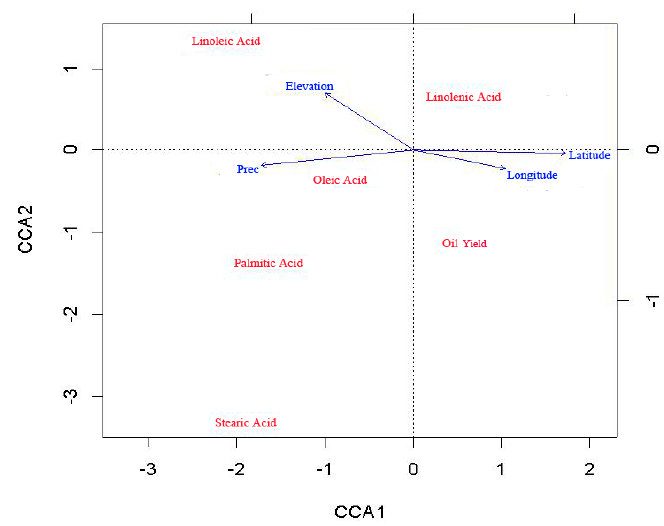
Figure 3. Triplot of oil and fatty acids variation in E. ulmoides seeds with environmental factors. Table 5. Results of canonical correspondence analysis of fatty acid content of E. ulmoides seed.